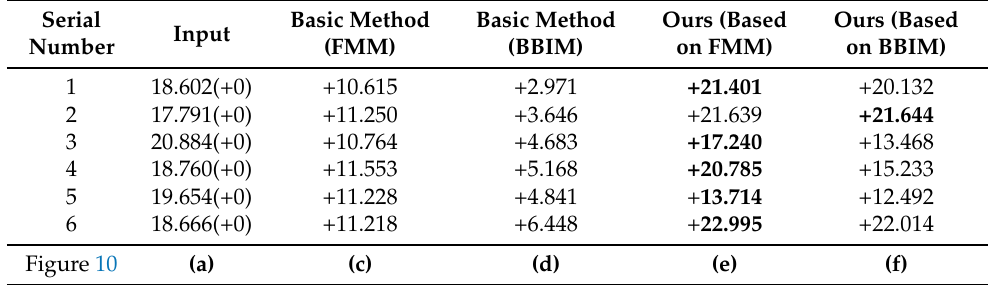
Table 2. RGB Image PSNR